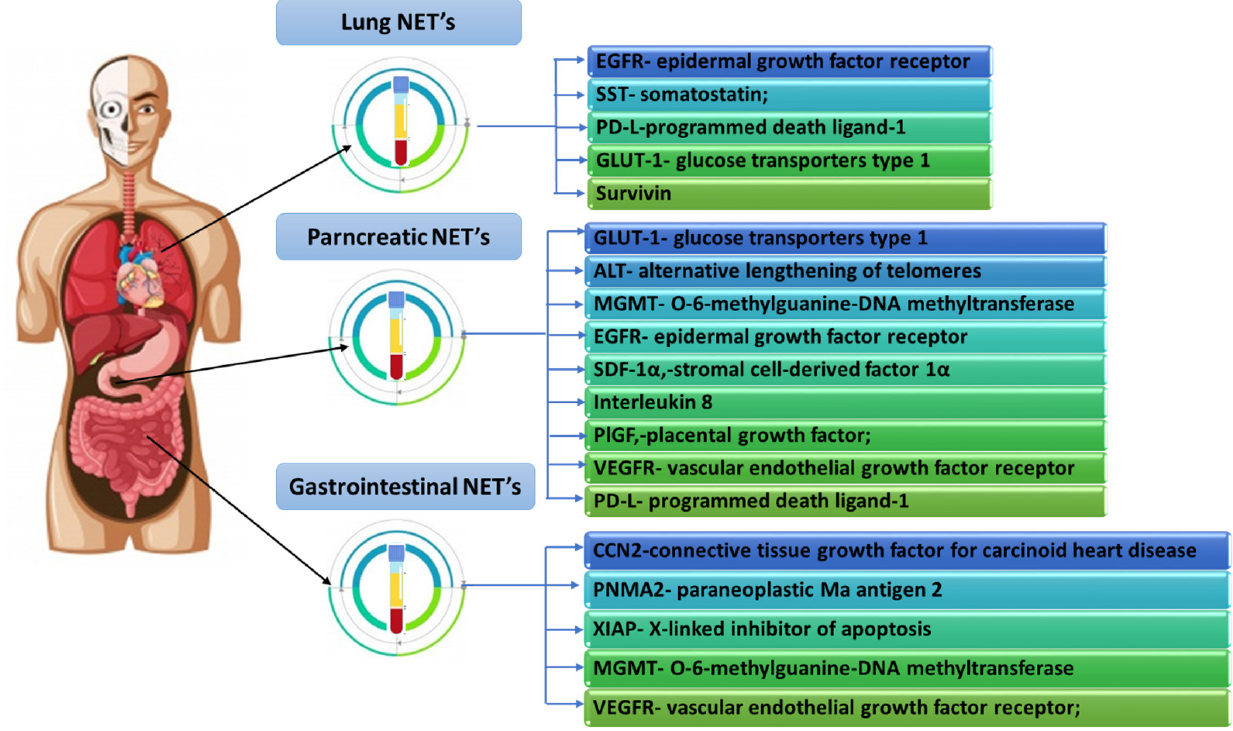
Figure 1. Selected examples of biomarkers determined in particular types of NET based on [39].